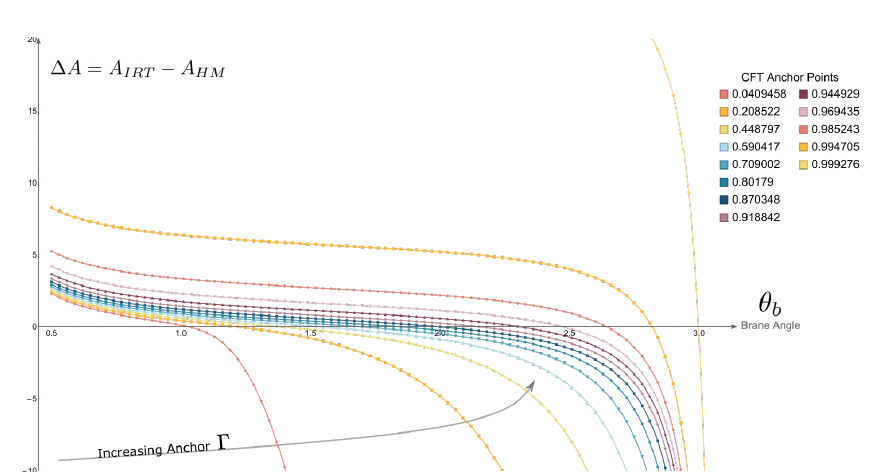
Figure 6 . The area difference is displayed as a function of brane angle θ b for many possible CFT anchor points Γ . The area difference is clearly monotonically increasing in Γ and monotonically decreasing in θ . The anchor points were determined numerically for many values of θ using the b HM shooting method with the boundary conditions in (2.9). The area difference diverges to negative infinity as Γ → 0 for θ , but when Γ → 0 for θ it converges to a finite value. b > θ c b < θ c